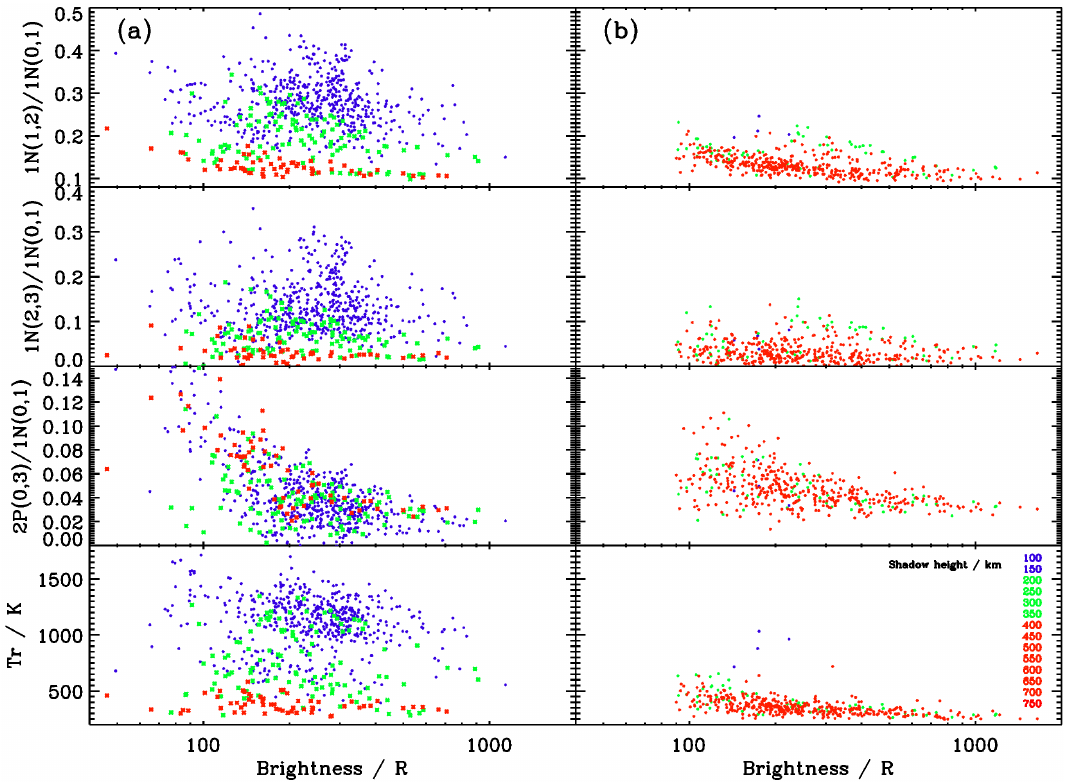
Fig. 12. Ratios of N + 1N (1,2)/(0,1), (2,3)/(0,1), N 2 2P (0,3)/1N (0,1) and rotational temperature as a function of N + 2 for (a) morning-day time and (b) evening-night time spectra. Solar shadow height (excluding screening height) is shown in colour.